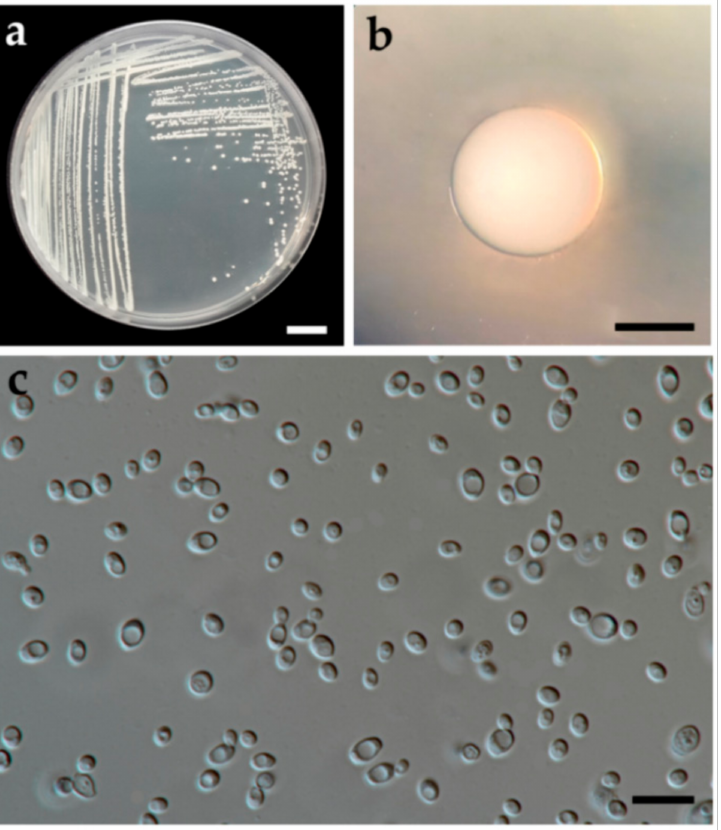
Figure 4. Wickerhamomyces lannaensis (holotype SDBR-CMU-S3-15). Culture ( a ), single colony ( b ) and budding cells ( c ) on YMA after two days at 30 ◦ C. Scale bar a and b = 10 cm, c = 10 µ m. Description: The streak culture on YMA after two days at 30 ◦ C is circular from (1–2 mm in diameter), white to cream color, smooth surface, dull-shining, entire margin, and raised elevation. After growth on YMA at 30 ◦ C for two days, the cells are spheroidal to short ovoidal (3.6–3.8 × 2.4–2.6 µ m), occur singly or in budding pairs. Pseudohyphae and true hyphae were absent. Ascospores were not obtained for individual strains and strain pairs on YMA, 5% MEA, PDA and V8 agar after incubation at 30 ◦ C for one month. Urea hydrolysis and diazonium blue B reactions are negative. Fermentation tests, glucose is delayed positive, but galactose, maltose, sucrose, trehalose, melibiose, lactose, raffi- nose, and xylose are negative. D-glucose, D-xylose, rhamnose, cellobiose, salicin, inulin (weak), glycerol, D-glucitol, D-mannitol, D-glucono-1,5-lactone, D-gluconate, DL-lactate (weak), succinate, and ethanol are assimilated. No growth was observed in L-sorbose, N-acetyl glucosamine, D-ribose, L-arabinose, D-arabinose, sucrose, maltose, α , α -trehalose, α -methyl-D-glucoside, melibiose, lactose, raffinose, melezitose, soluble starch, erythritol, ribitol, galactitol, myo-inositol, 2-ketogluconic acid, 5-ketogluconic acid, D-glucuronate, D-galacturonic acid, citrate, methanol, and xylitol. For the assimilation of nitrogen